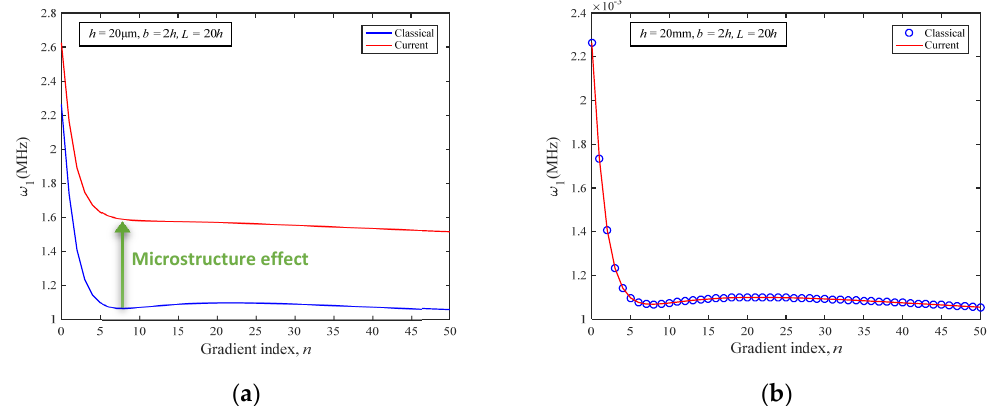
Figure 12. Natural frequency of the MEE-FGM beam for different gradient index with ( a ) h = 20 μ m, ( b ) h = 20mm.